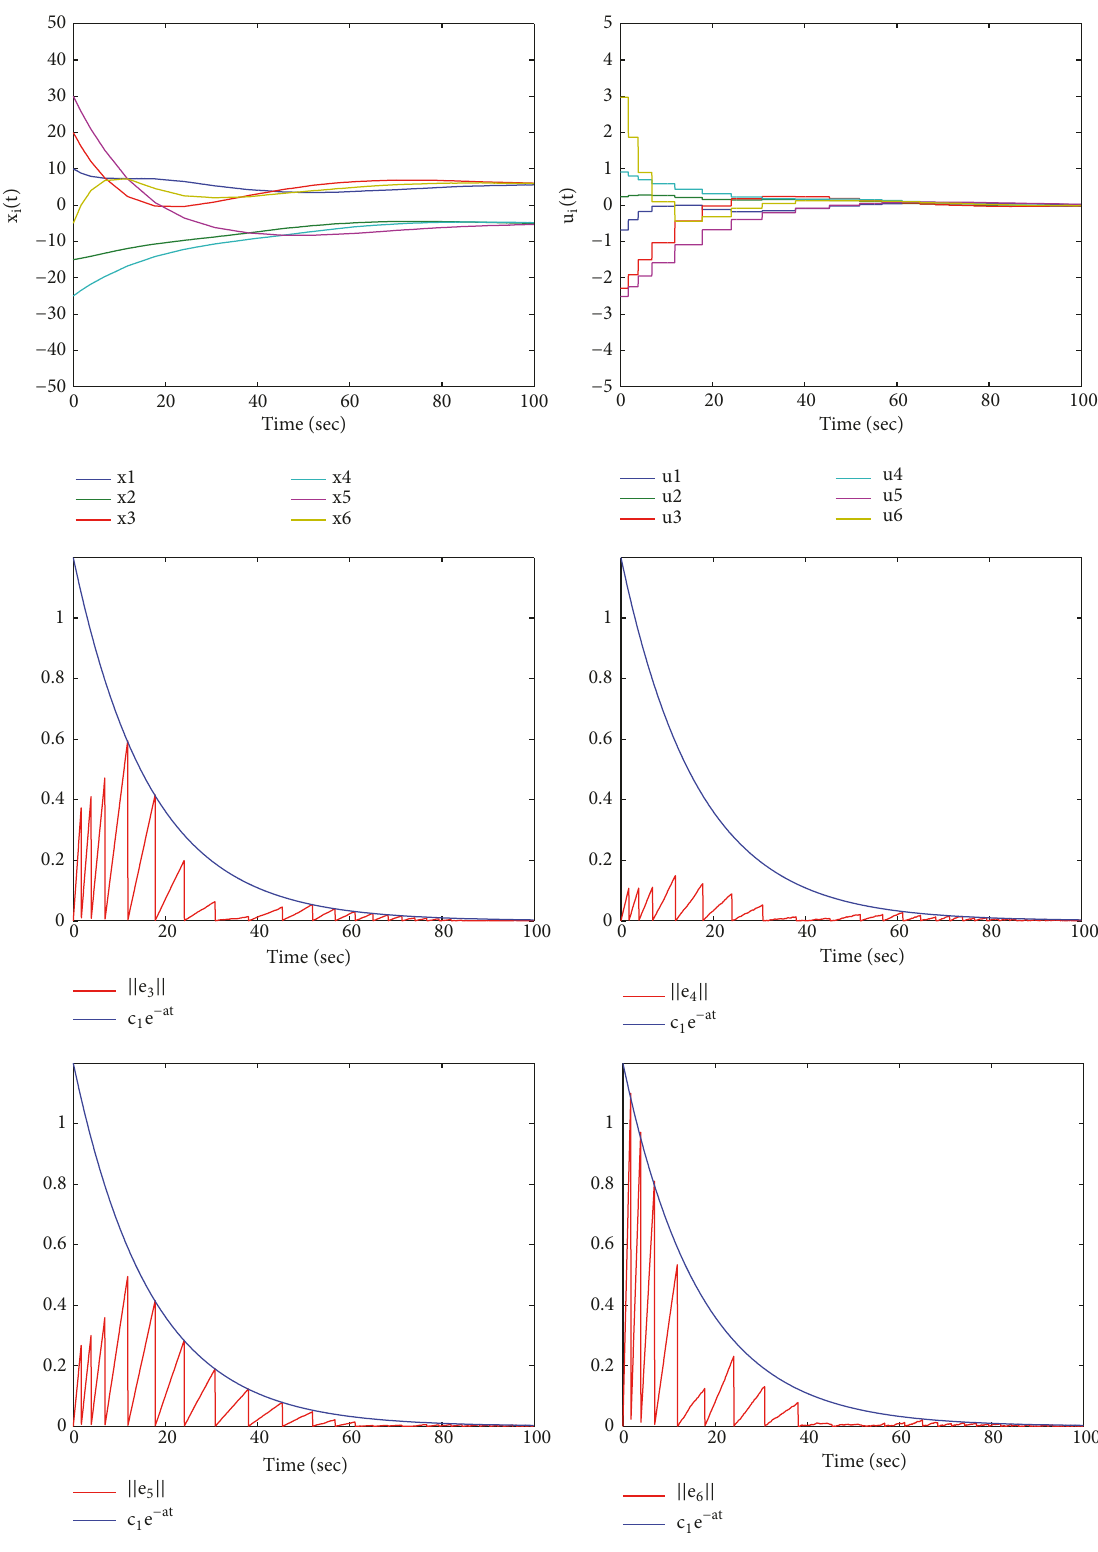
Figure 4: The evolution of error